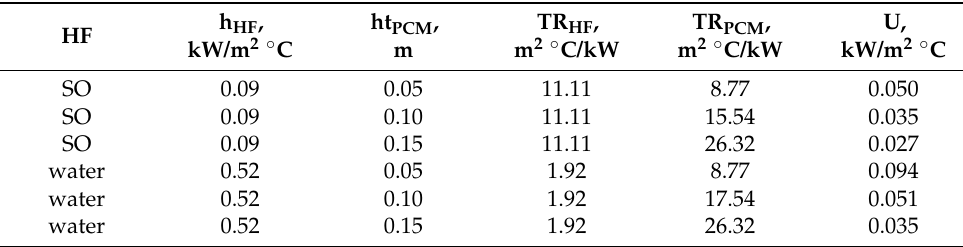
Table 5. Thermal resistances (TRs) in the latent heat storage tank (LHST).